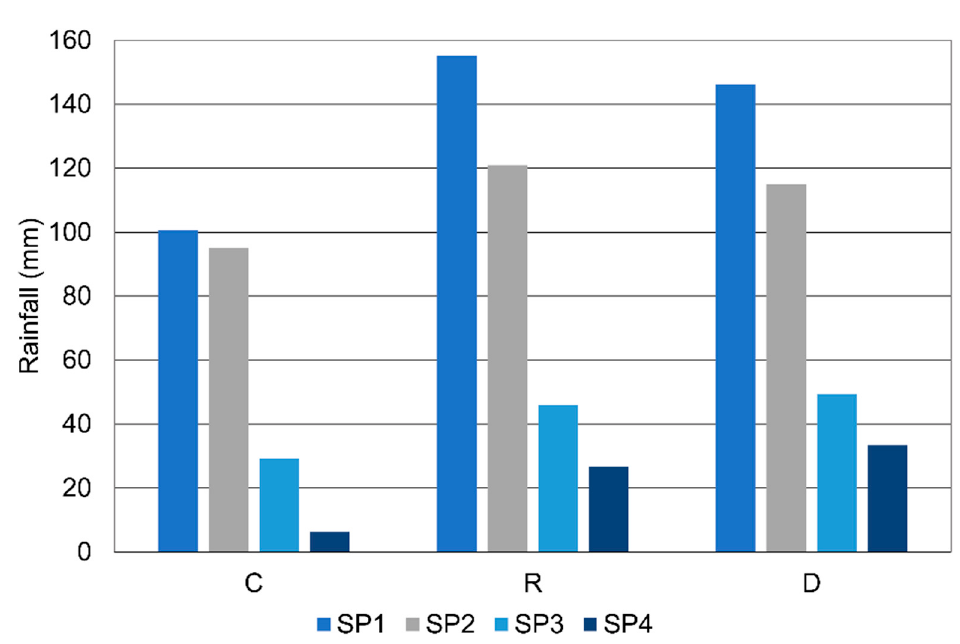
Figure 7. Average rainfall during the two months of each sampling survey (SP1, SP2, SP3, and SP4) for Celestun (C), the Recharge zone (R) and Dzilam Bravo (D).